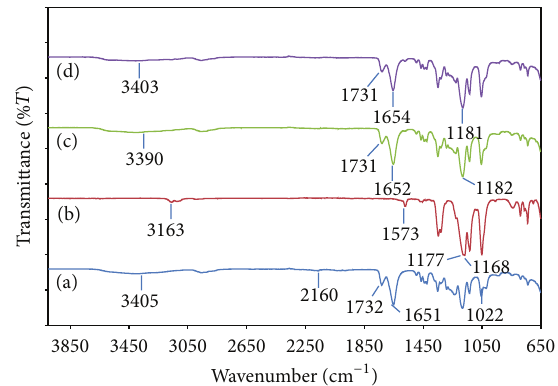
Figure 7: FTIR spectra for (a) EMIm 0, (b) pure EMIm TFSI, (c) EMIm 10, and (d) EMIm 25.